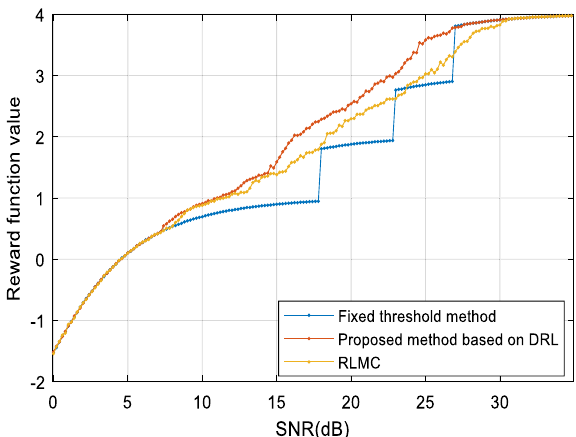
Fig. 15 Average reward function value in simulated